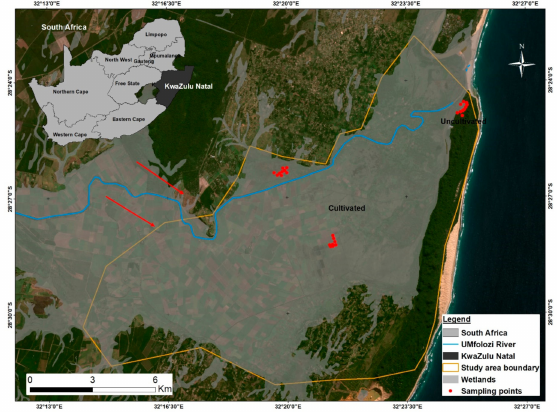
Figure 1. Study area: The uMfolozi floodplain in uMkhanyakude District Municipality. Red arrows show west to east water flow towards the Indian